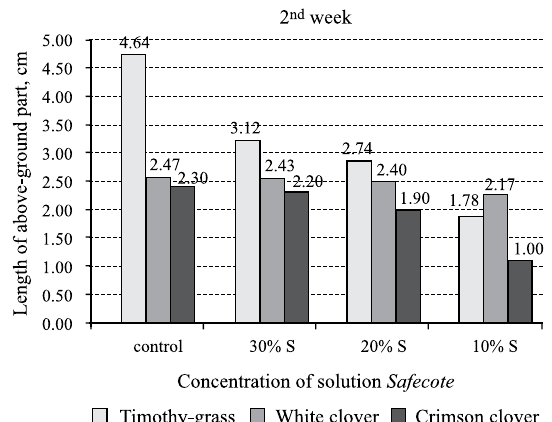
Fig. 4. Length of above-ground part of grass vegetation after 2 nd week of